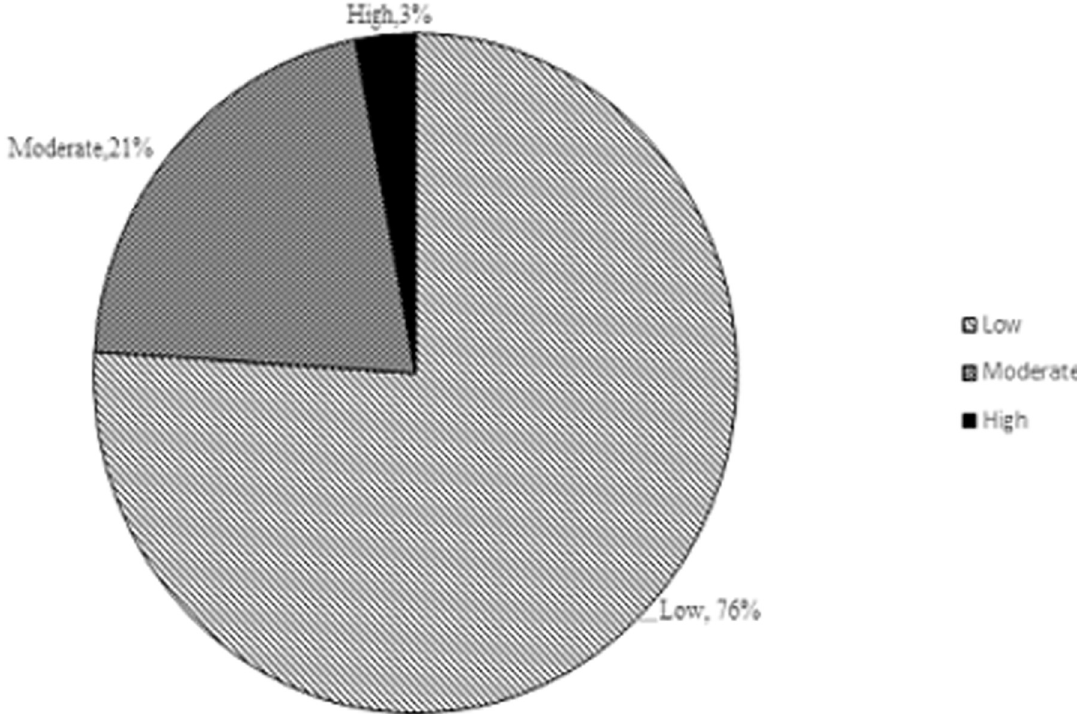
Fig 2. Intangible cost of breast cancer